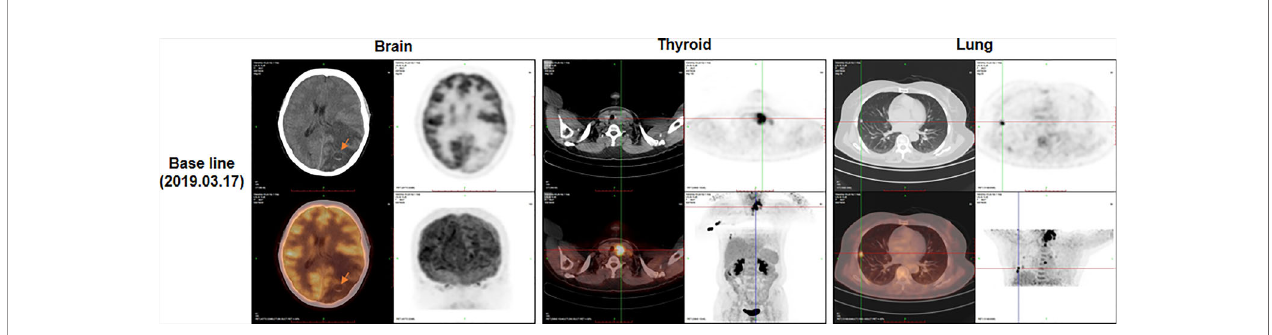
FIGURE 1 | The positron emission tomography-computed tomography (PET-CT) at baseline (before surgery). PET-CT showed masses in brain (arrow), thyroid and